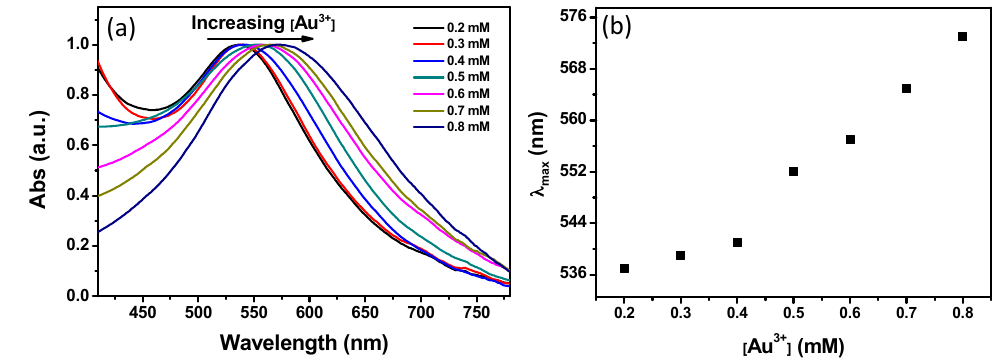
Figure 2. ( a ) Normalized UV-VIS diffuse reflectance absorption spectra of WP-Au corresponding to different concentrations of Au ions; and ( b ) a plot of the wavelength of the absorption peak as a function of Au ion concentration.